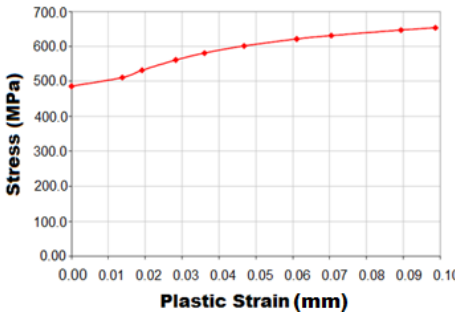
Figure 3. Stress versus plastic strain according to the data obtained in an experimental study of